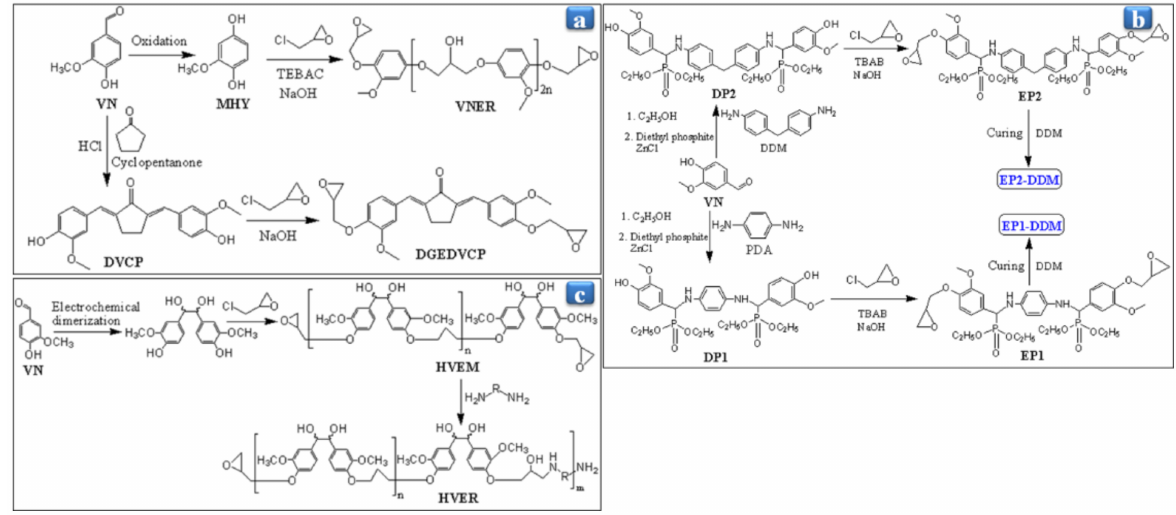
Figure 8. An illustration schematic reaction of ( a ) VNER and DGEDVCP, ( b ) EP1-DDM and EP2-DDM, and ( c ) HVEM and